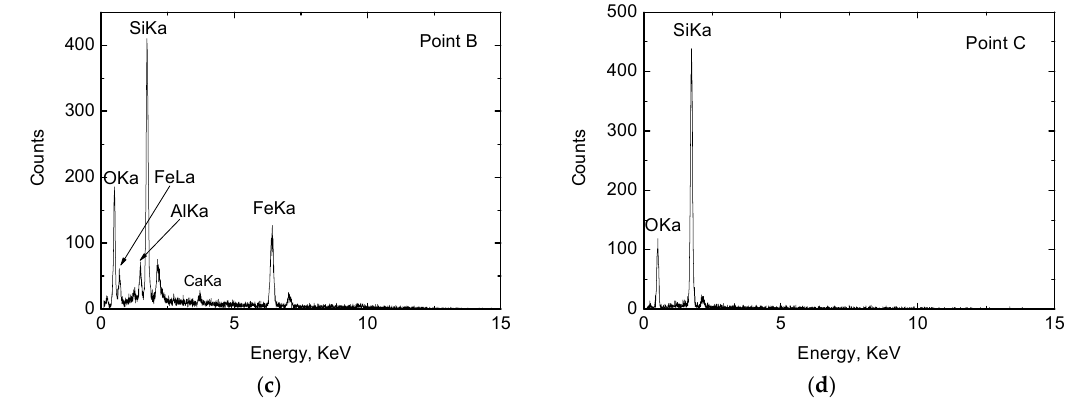
Figure 8. Typical metallographic picture and energy disperse spectroscopy of direct reduced iron (DRI) (C/O = 0.95, 50 min, 2nd layer): ( a ) metallographic picture; ( b ) point A; ( c ) point B; ( d ) point C.